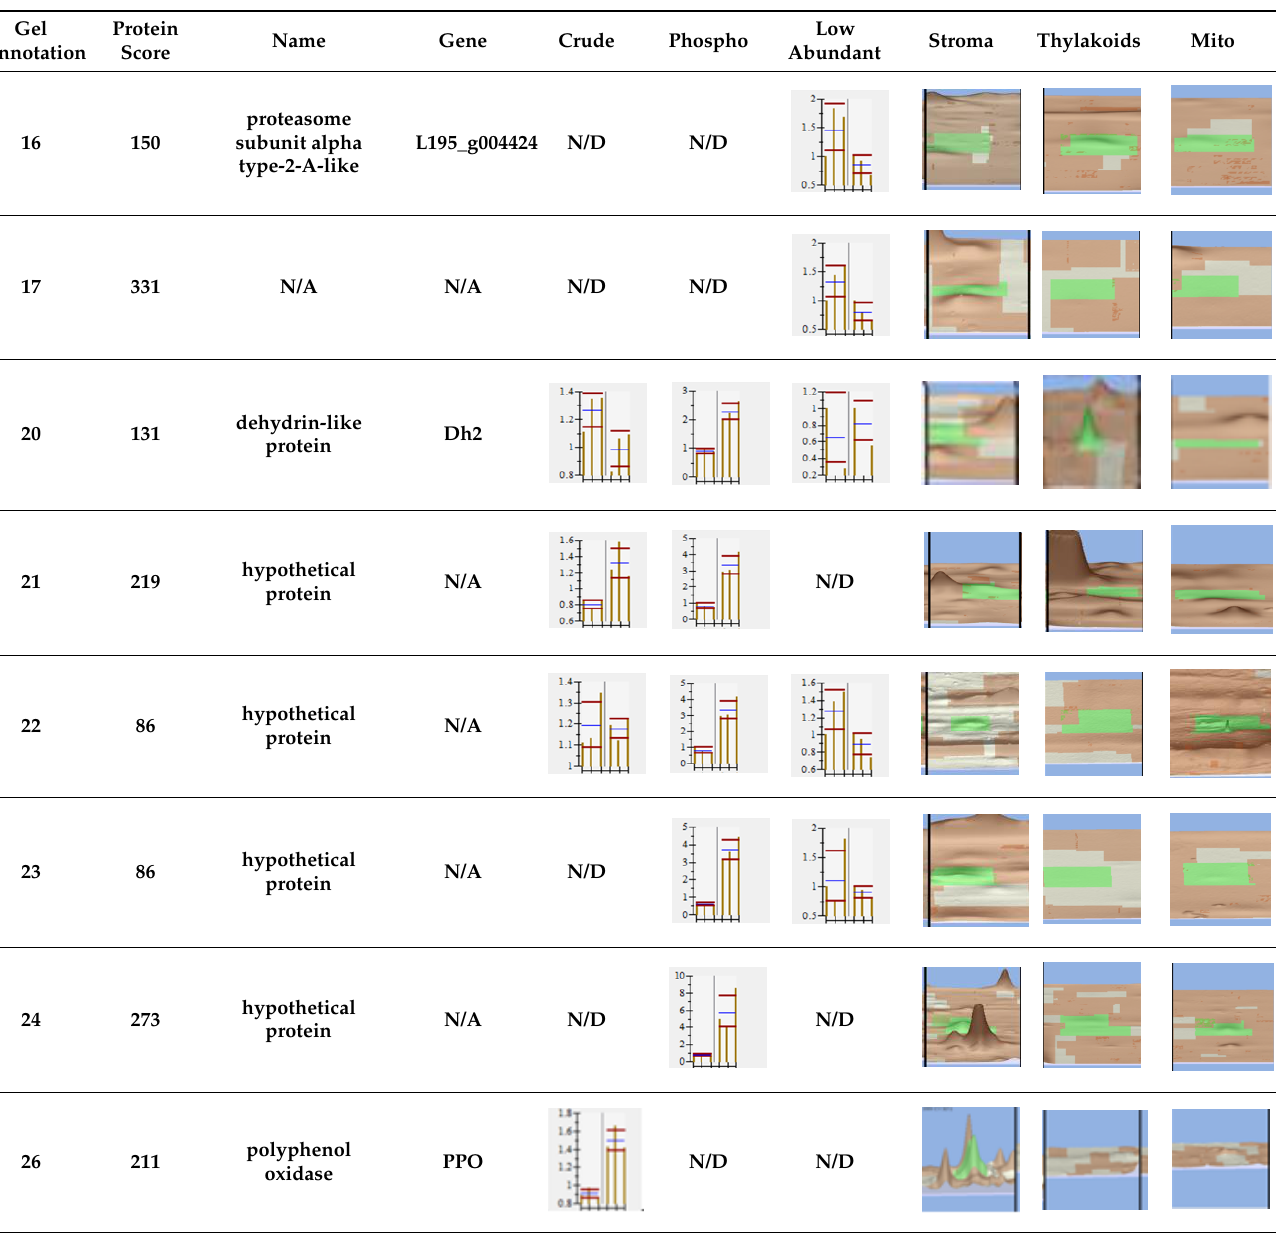
Int. J. Mol. Sci. 2022 , 23 , 8520